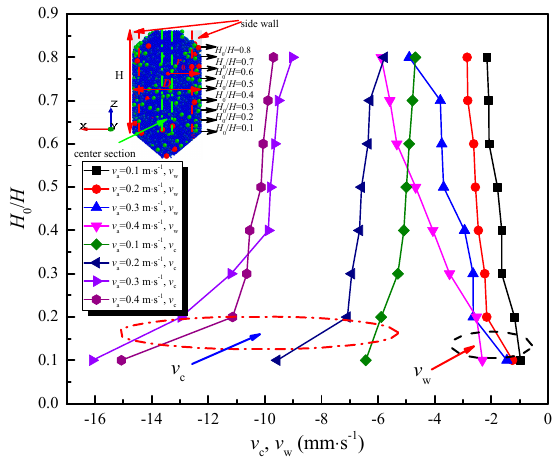
Figure 30. The variation in v w , v c along the height of the sinter layers with variations in the discharge velocity.